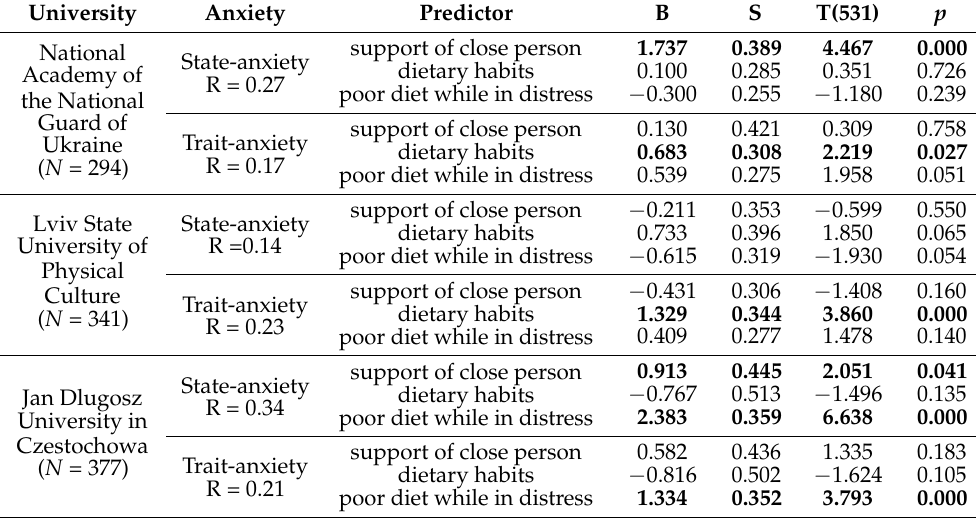
Table 3. Regression models grouped by university of participants ( p < 0.05).